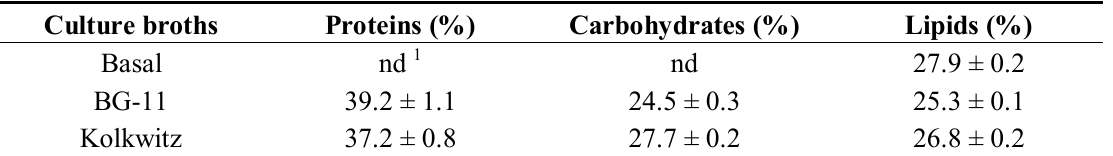
Table 2. Biomass composition of the Chlorella cells harvested at the end of the batch growth regimen using three different culture